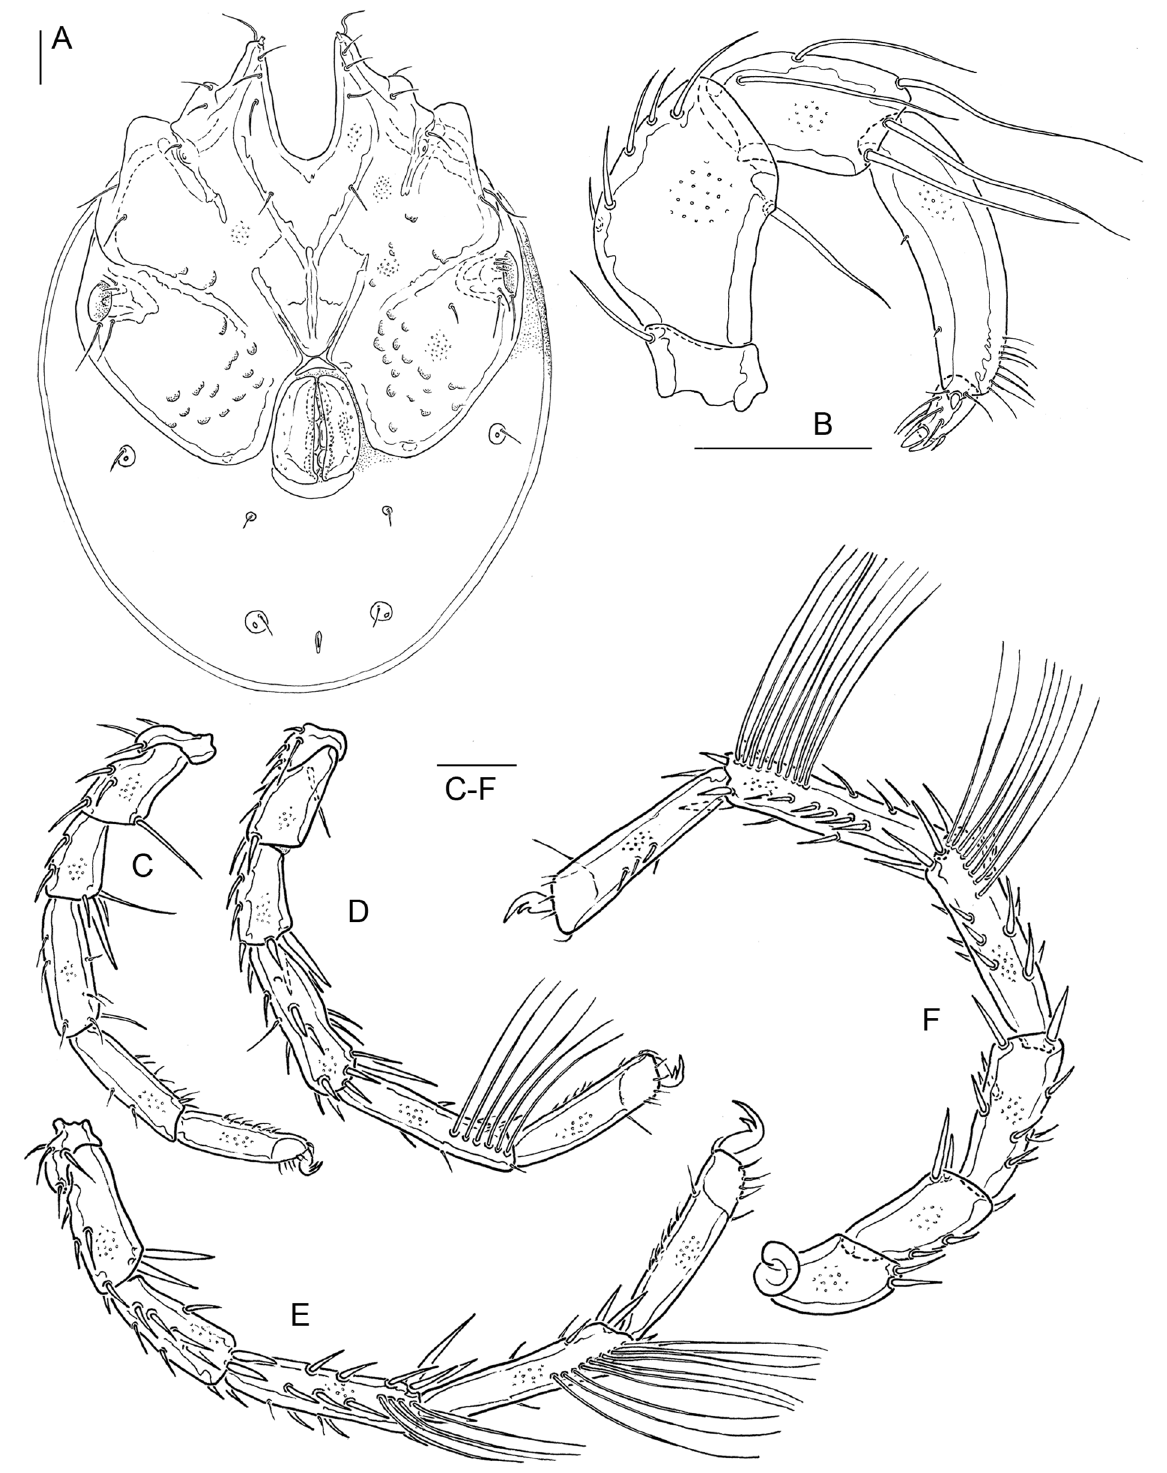
Fig. 7. Lebertia ( Pilolebertia ) porosa Thor, 1900, ♂ from the type locality. A . Venter. B . Palp. C . I-L. D . II-L. E . III-L. F . IV-L. Scale bars = 100